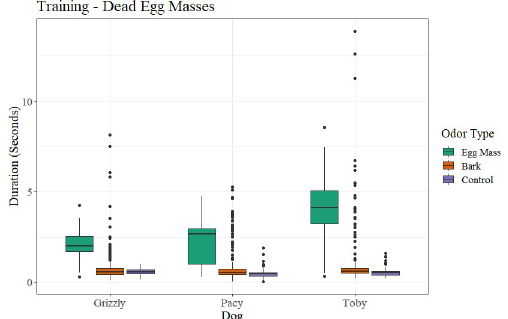
Fig 9. Duration that each dog spent at each port by what was in each port (either egg masses, bark, or controls) for dead spotted lanternfly egg masses during training.